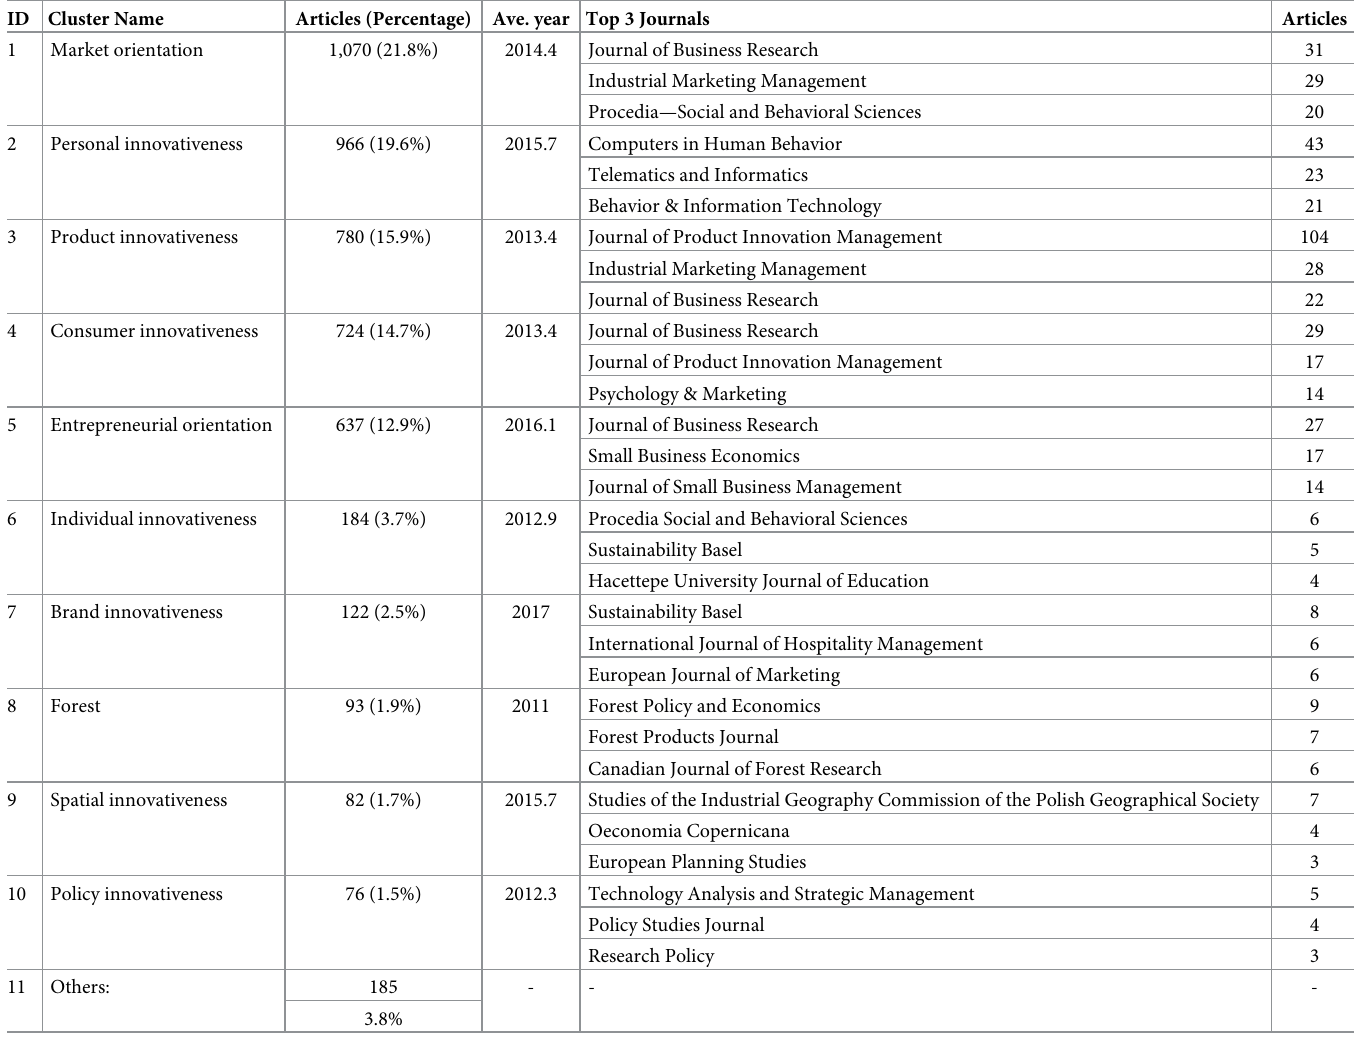
Table 3. The top 10 clusters of innovativeness research named using the dominant theme with the most important quantitative data (number of articles, average publication year, top three journals, and number of articles in each journal) until